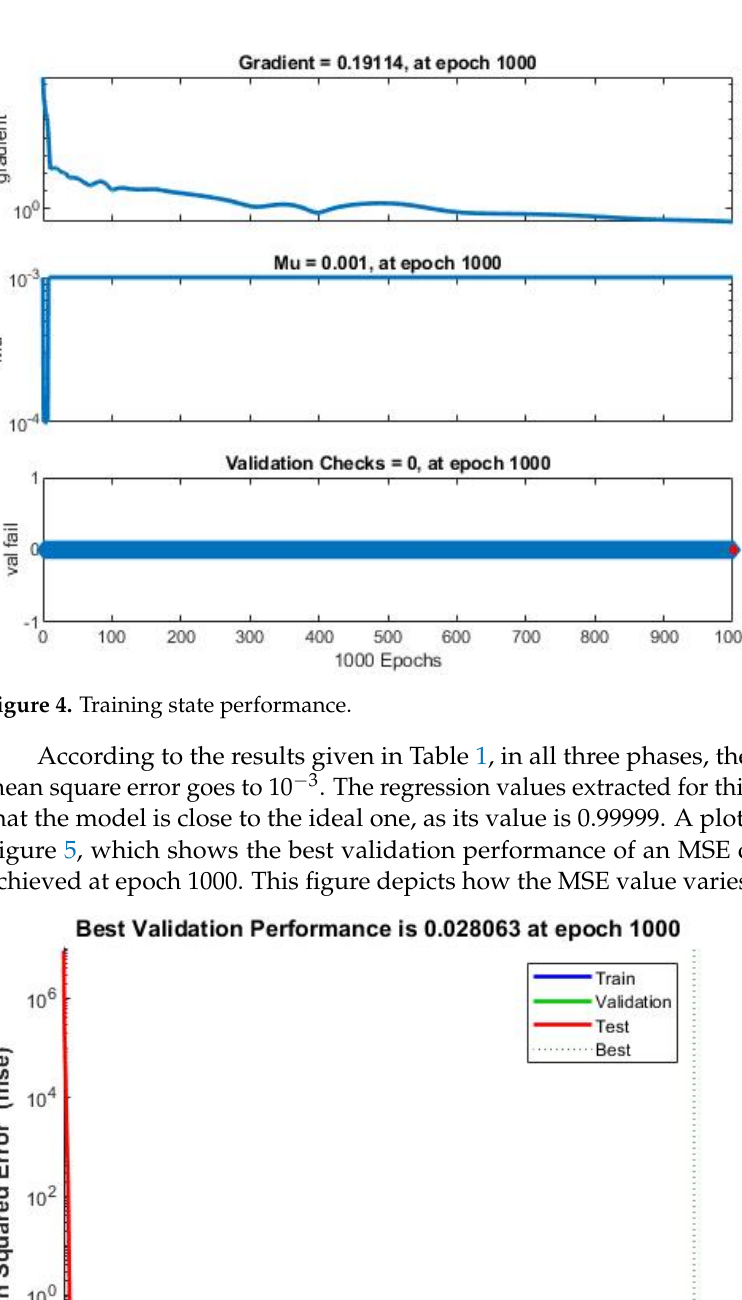
Figure 6. Error histogram for training, validation, and testing.